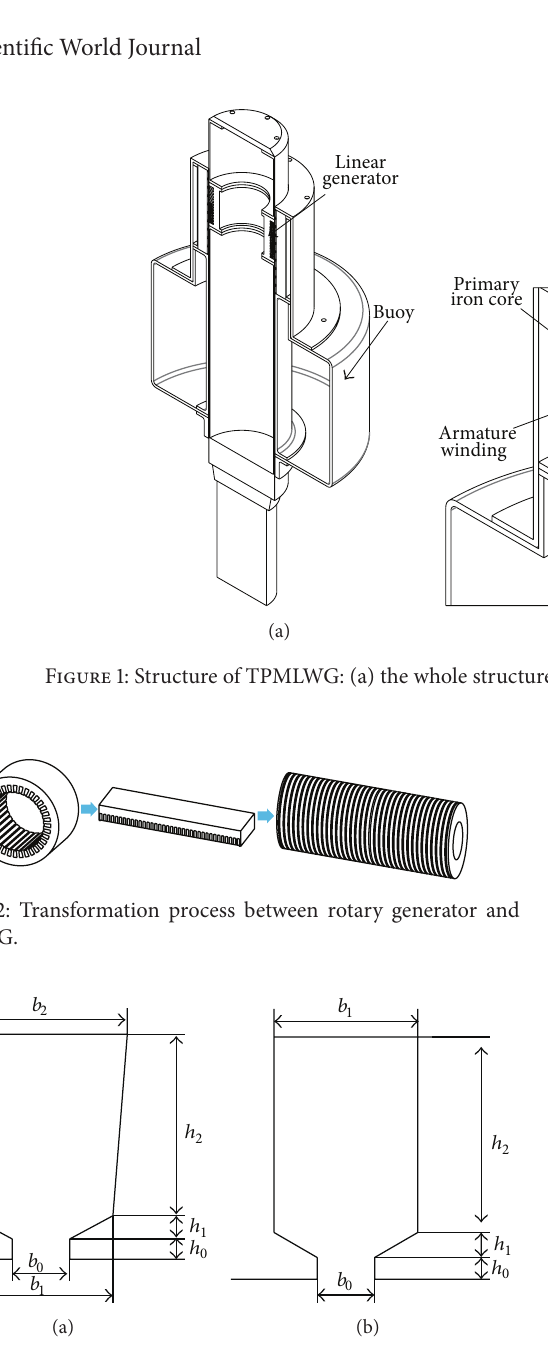
Figure 3: Slot shape of permanent magnet generator: (a) slot shape of permanent magnet rotation generator and (b) slot shape of TPMLWG.